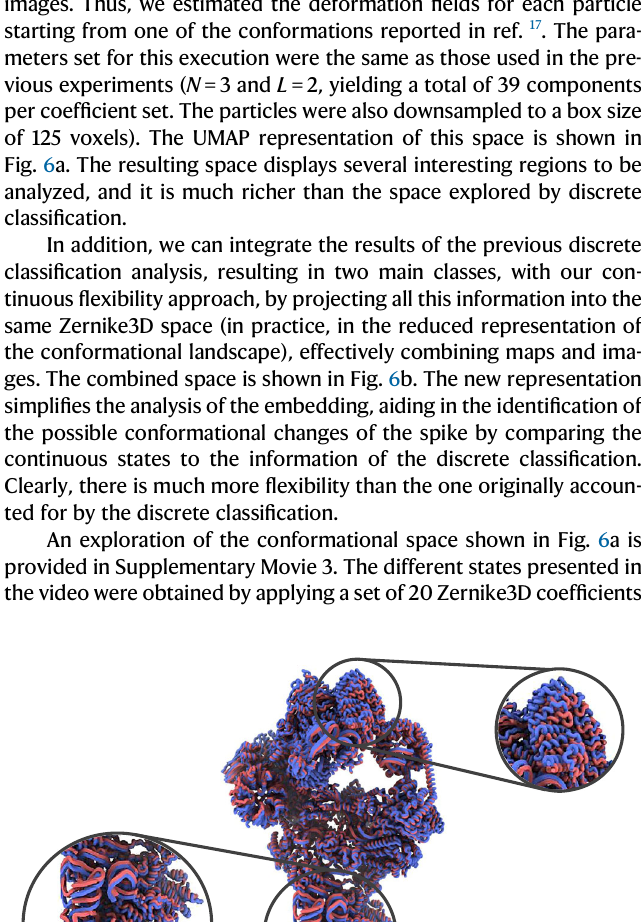
describedinref. 17 .Thankstothecombinedanalysis,wecandetectacleargroupof particles corresponding to an unidenti fi ed conformation in the dataset. The col- with the conformation estimated for every particle.